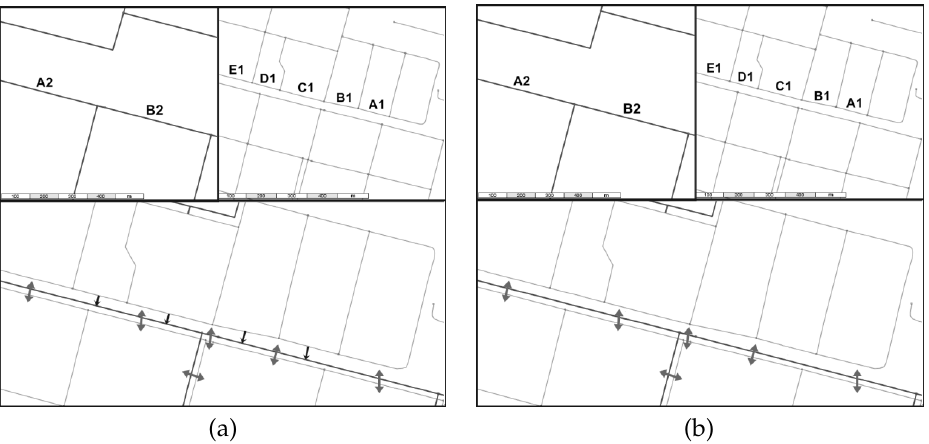
Figure 6: Matching results with (a) and without (b) the Neighborhood Criterion . In both sub- figures, the less detailed dataset (BDCARTO) is represented in the upper left corner, and the most detailed dataset (MultiNet) in the upper right corner. Both dataset are overlapped in the bottom. Single arrows represent wrong-matched links and double arrows represent correct